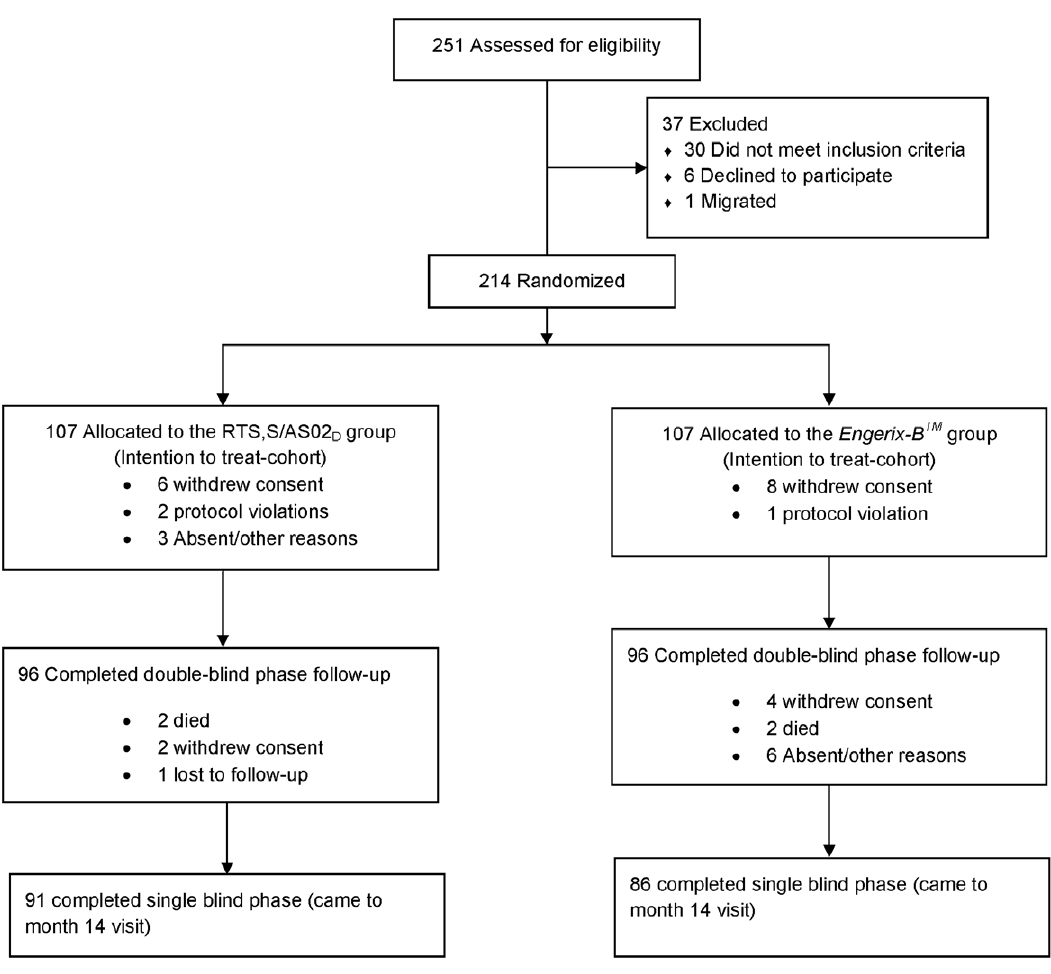
Figure 1. Trial Profile.